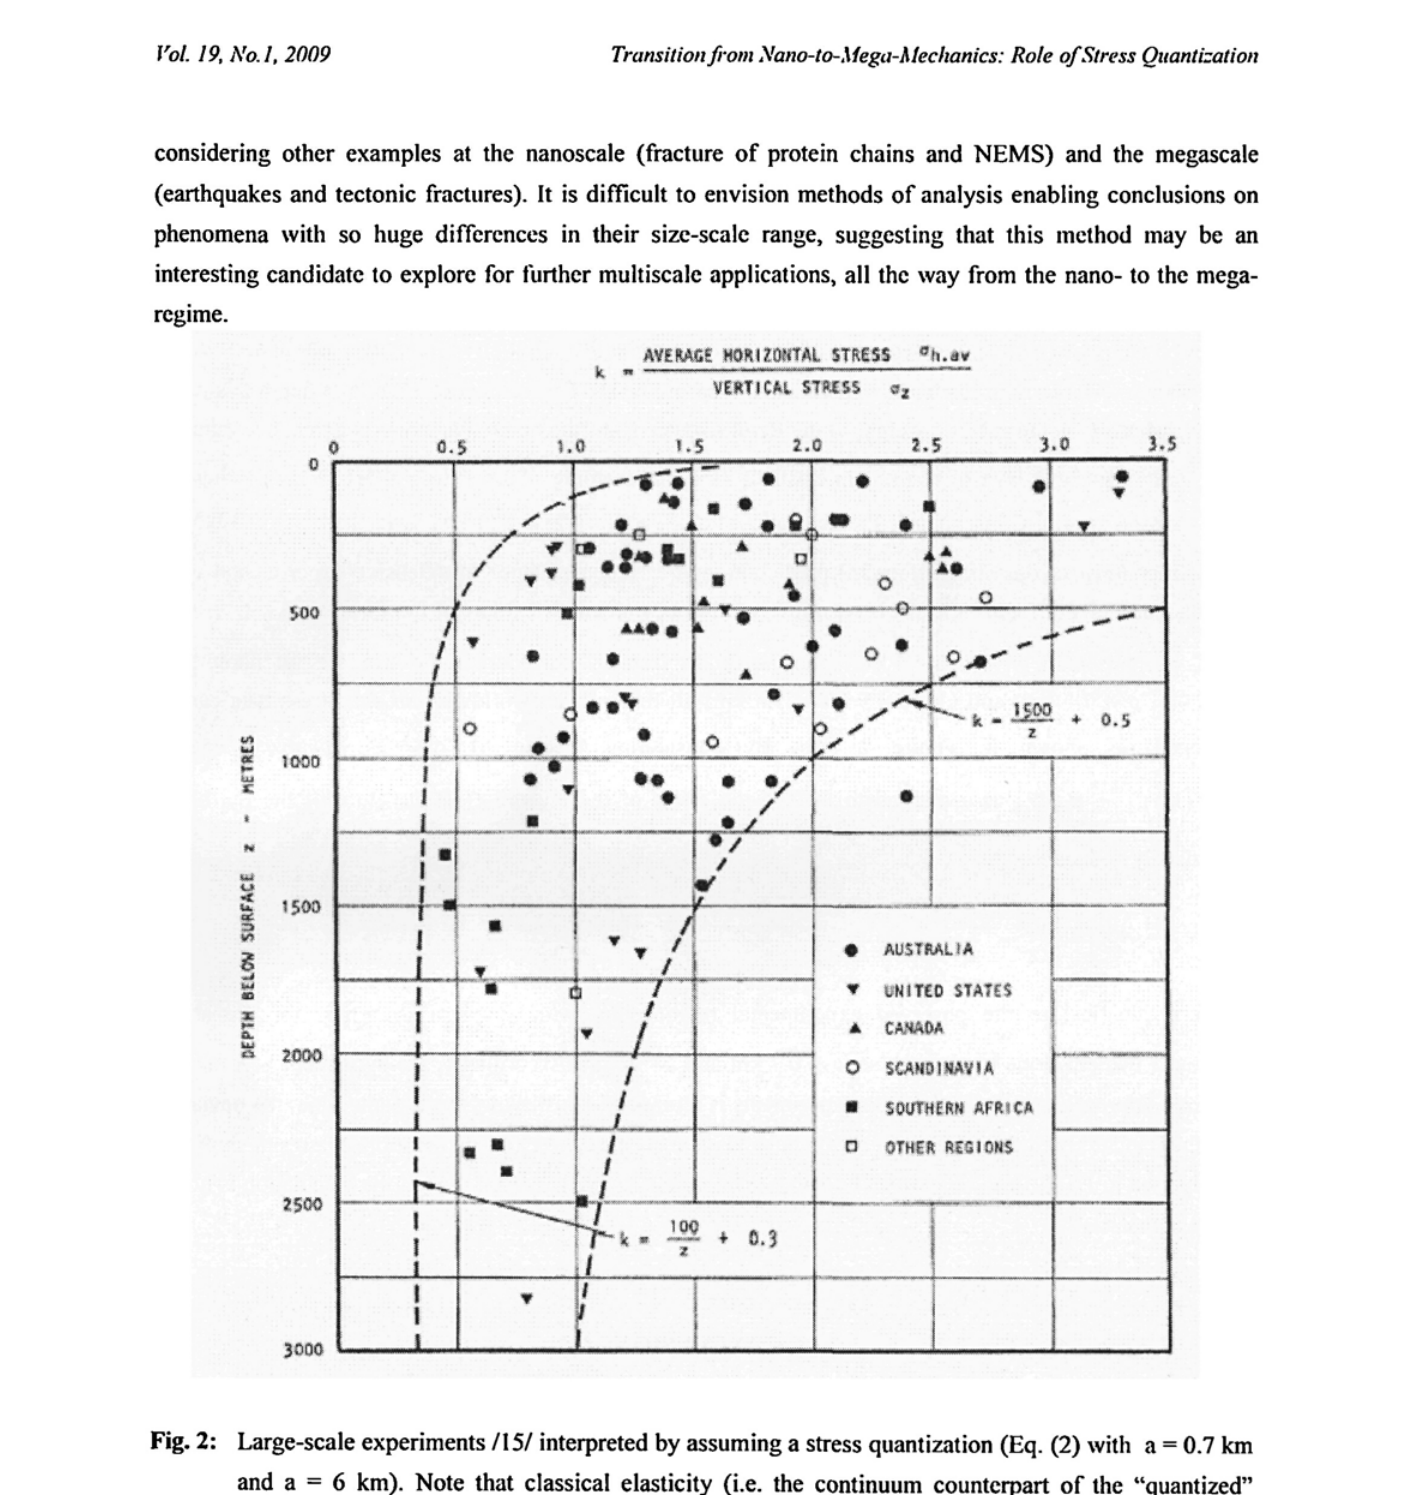
Fig. 2: Large-scale experiments /15/ ίηΙεφΓεΙεα by assuming a stress quantization (Eq. (2) with a = 0.7 km and a = 6 km). Note that classical elasticity (i.e. the continuum counterpart of the "quantized" approach) would trivially yield a vertical straight line at -0.4, independently of the depth below the Earth's surface. Thus, the role of the stress quantization is